Question: What does this figure show? Answer in one sentence.
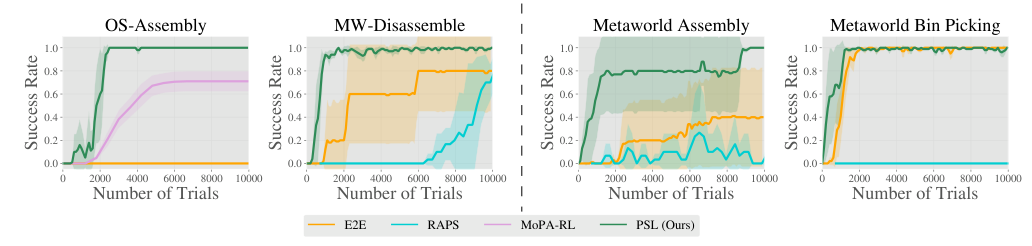
Answer: Sample Efficiency Results. We plot task success rate as a function of the number of trials. PSL improves on the sample efficiency of the baselines across each task in Robosuite, Kitchen, Meta-World, and Obstructed Suite. PSL is able to do so because it initializes the RL policy near the region of interest (as predicted by the Plan and Sequence Modules) and leverages local observations to efficiently learn interaction. Additional learning curves in Appendix C.